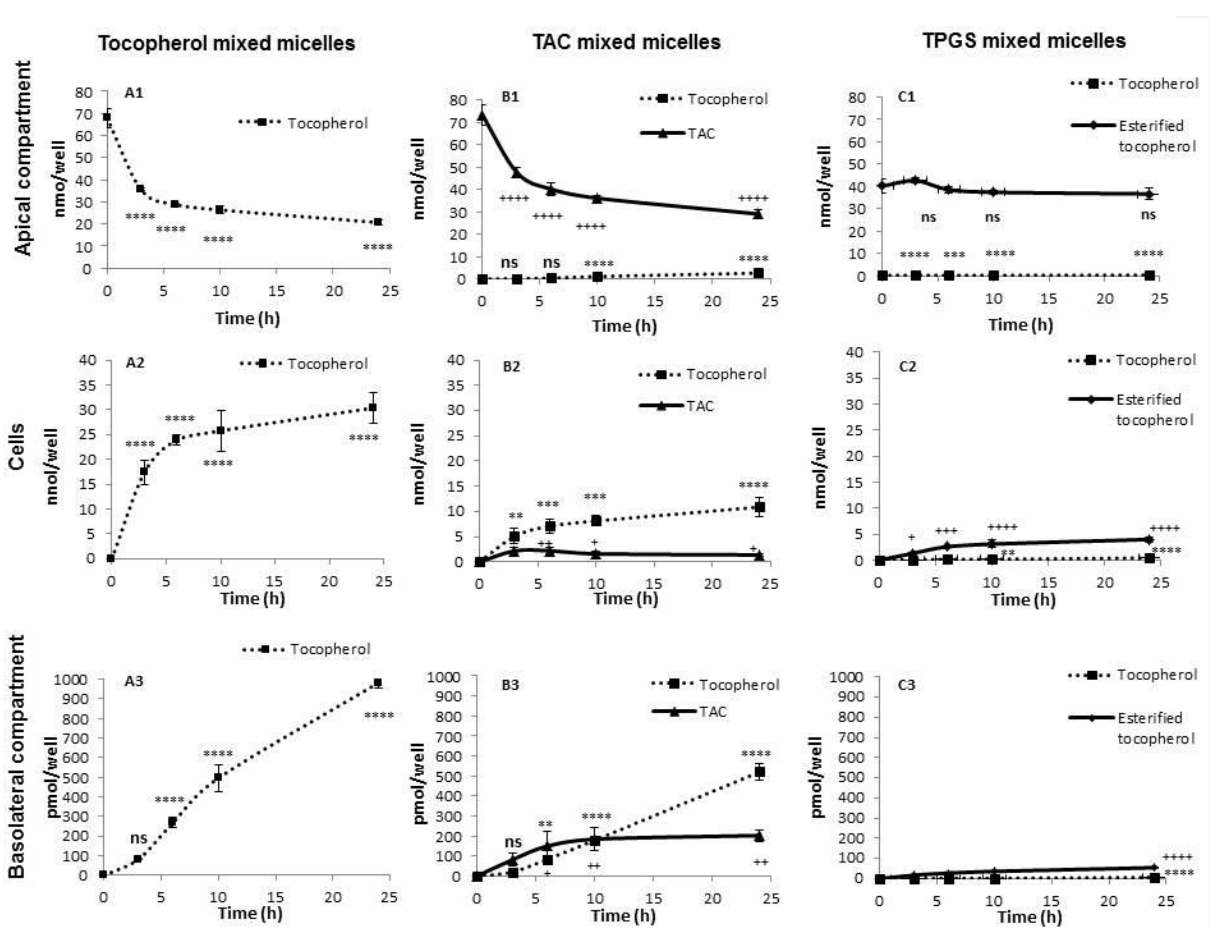
Figure 3. Uptake and secretion of different forms of tocopherol by Caco-2 cells. Two weeks post-confluence Caco-2 cells were incubated with tocopherol- or tocopherol acetate (TAC)- or α-tocopheryl polyethylene glycol succinate 1000 (TPGS)-rich mixed micelles up to 24 h and, following lipid extraction, TAC and tocopherol amounts were measured by HPLC in the different compartments. For the TPGS condition, esterified tocopherol was determined indirectly by measuring the tocopherol before and after saponification of the different compartments. ( A1 )–( A3 ) Tocopherol amounts in the apical, cellular, and basolateral compartment upon incubation with tocopherol-rich mixed micelles. ( B1 )–( B3 ) TAC and free tocopherol amounts in the apical, cellular, and basolateral compartment upon incubation with TAC-rich mixed mi- celles ( C1 )–( C3 ) Esterified tocopherol and free tocopherol amounts in the apical, cellular, and basolateral compartment upon incubation with TPGS-rich mixed micelles. For each vehicle and for each time point, n = 3. Values are means of amounts with their standard errors represented by vertical bars. Tukey test with time as a factor were carried out. * p < 0.05; ** p < 0.01; *** p < 0.001; **** p < 0.0001, ns = non-significant. (* are for tocopherol and are replaced by + for TAC and esterified tocopherol). Abbreviations: TAC: tocopherol acetate; TPGS: α-tocopheryl polyethylene glycol succinate 1000.